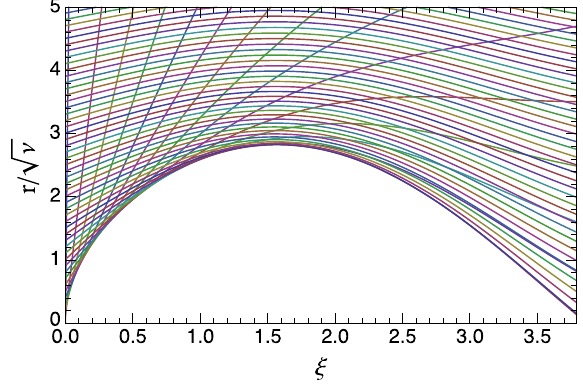
ffiffiffi p ν and ξ